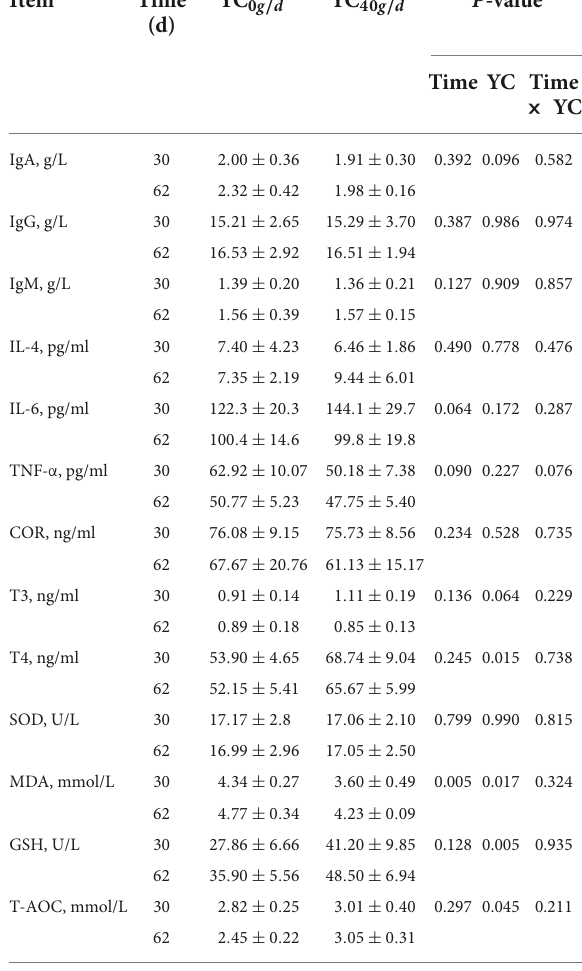
TABLE 6 Effect of feeding YC on the immunological function, anti-stress, and antioxidant parameters in the serum on days 30 and